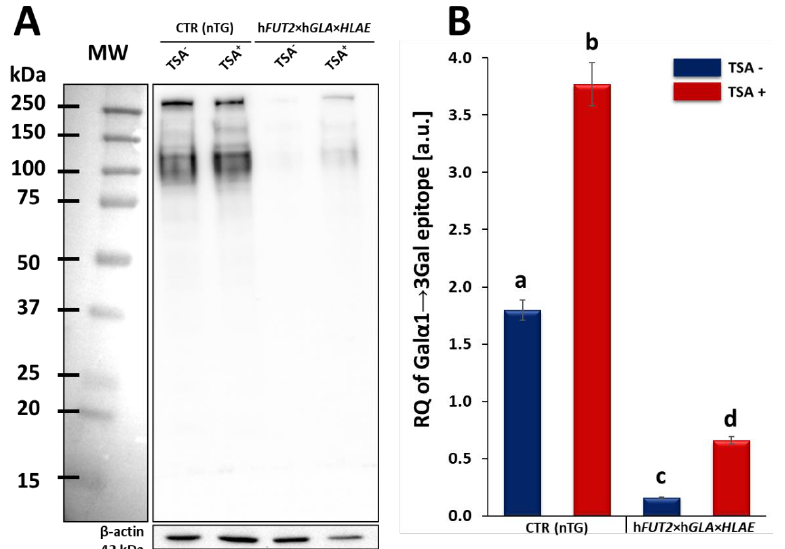
Figure 5. Lectin blot analysis of Gal α 1 → 3Gal epitope expression at the protein level in the ex vivo- expanded porcine h FUT2 ×h GLA × HLA-E tri-transgenic (3×TG) and control non-transgenic (CTR nTG) ACFCs epigenetically transformed (TSA + ) or not transformed with trichostatin A (TSA − ). ( A ) Representative lectin blots of the expression of Galα1 → 3Gal (α -Gal) epitopes in TSA − and TSA + ex vivo proliferating ACFCs established from dermal tissue explants stemming from CTR nTG and 3×TG pigs. MW indicates the molecular weight of protein standards (Precision Plus Protein TM Dual Color Standards, Bio-Rad). Each band represents a glycosylated prote in containing the Galα1 → 3Gal antigenic determinant. β -Actin provided a loading control for all the analyzed samples. ( B ) The semi- quantitative analysis of relative expression pinpointed for Galα1 → 3Gal epitopes (in arbitrary units). Relative optical density (ROD) from three separate analyses of at least three animals for each variant is expressed as mean. Graph bar shows the mean ± SEM. Statistics: one-way ANOVA and Newman – Keuls post hoc test. The bars marked with different letters vary significantly. Values denoted as a-b: p < 0.01; a-c, a-d, b-c, b-d, c-d: p < 0.05. It is worth highlighting that the semi- quantitative profile of Galα1 → 3Gal epitopes dwindled significantly in TSA-untransformed and transformed ACFCs stemming from h FUT2 ×h GLA × HLA-E triple-transgenic pigs as compared to the TSA-unexposed and exposed ACFCs originating from CTR nTG specimens. Nonetheless, the protein samples isolated from TSA-unmodulated 3×TG ACFCs exhibited the significantly lowest relative abundance (RA) noticed for Galα1 → 3Gal epitopes. Taking into consideration both tri- genetically modified and non- modified ACFCs, RAs estimated for Galα1 → 3Gal antigenic determinants increased significantly in protein samples derived from TSA + cells as compared to those recognized for their protein counterparts extracted from TSA − cells. However , the level of α - Gal epitopes pinpointed for TSA-modulated 3×TG ACFCs was still profoundly lower than the semi- quantitative profiles of α -Gal antigenic determinants observed in TSA-modulated and unmodulated CTR nTG ACFCs. 3. Discussion The use of swine tissues and organs seems to be a response to the current shortage of organs for allogeneic transplantation in humans, considering also a paucity of human dermo-integumentary allografts. However, due to hyperacute rejection, which is the main obstacle in pig-to-human xenotransplantation, genetically modified pigs need to be propagated and multiplied [4]. Currently, many methods of genetic modification are available. At first, they encompass the generation of homozygous pigs lacking the gene coding for α1,3 - galactosyltransferase (α1,3 -GT) for the purpose of depletion of anti-pig